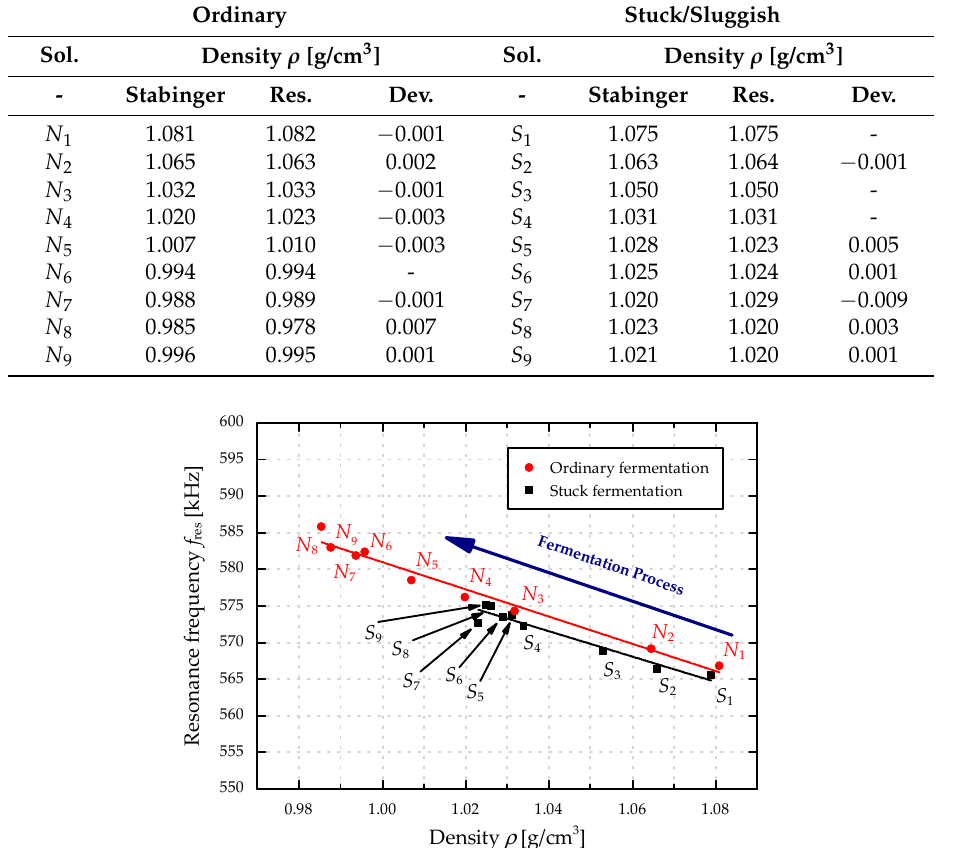
Table 4. Determined density values (Res.) for ordinary and stuck/sluggish model solutions and their comparison to reference values ( Stabinger ) obtained with a Stabinger SVM3000 viscometer.